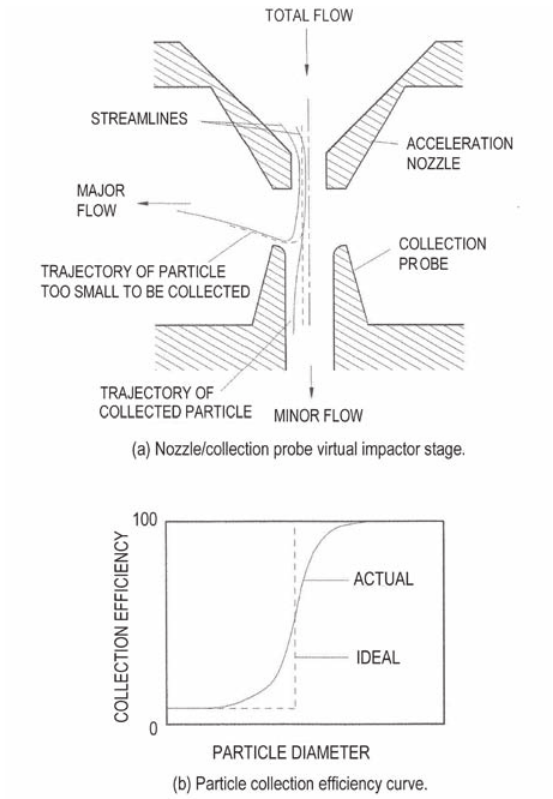
Fig. 1 Virtual Impactor Stage and Particle Collection Efficiency